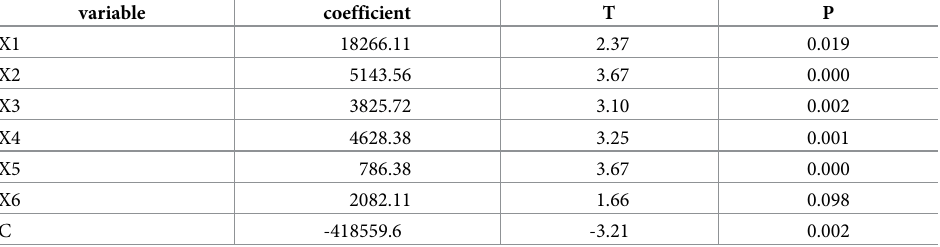
Table 4. Result of the panel data